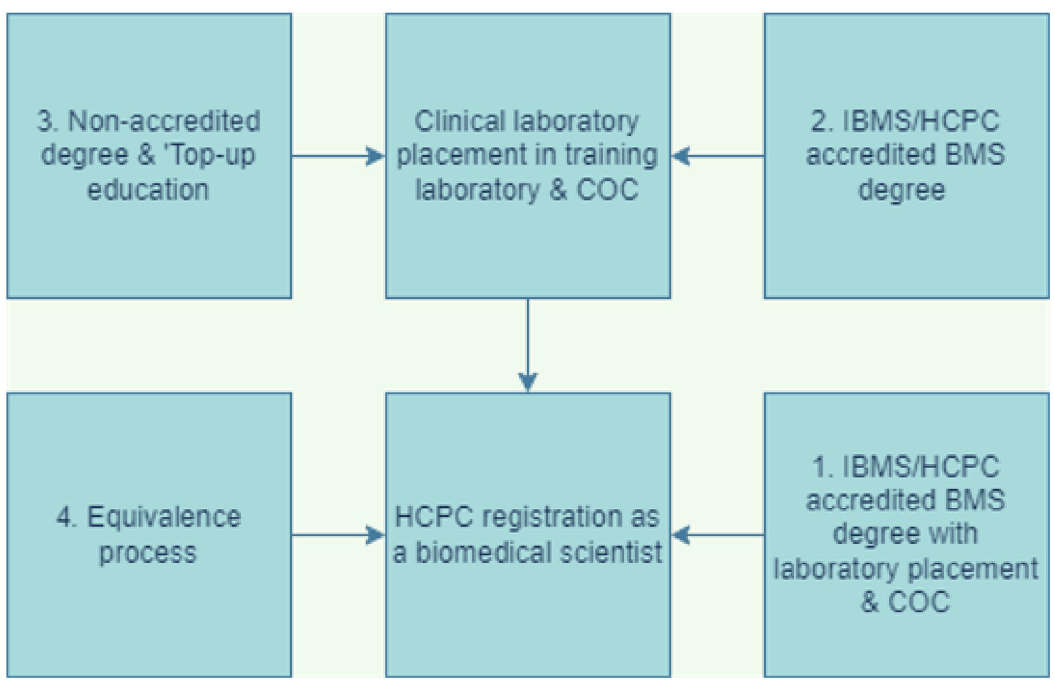
Fig 1. The four routes to health and care professions council (HCPC) registration for biomedical scientists ‘Top-up’ education: Refers to supplementary education needed to meet the HCPC requirements. Equivalence process: refers to the route used for laboratory scientists that work at the level of BMS and want to register as a BMS but that are not HCPC registered, (adapted from information from Institute of Biomedical Science on becoming HCPC registered [9]). COC: certificate of competence; IBMS: institute of biomedical science; HCPC: health and care professions council, BMS: biomedical